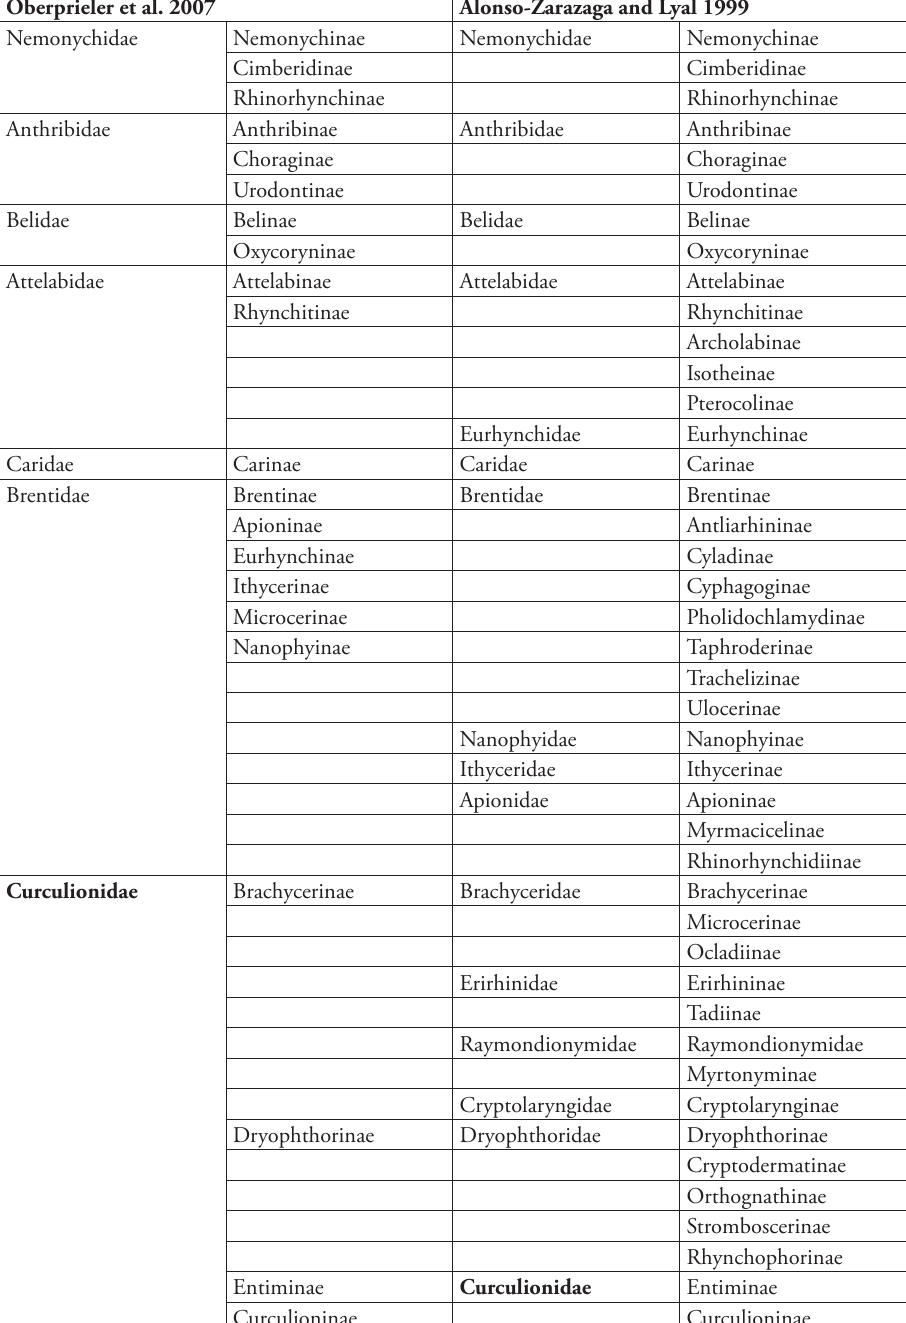
Table 2. Comparison of weevil classification of extant families as more broadly defined by Oberprieler et al. (2007) and more narrowly defined by Alonso-Zarazaga and Lyal